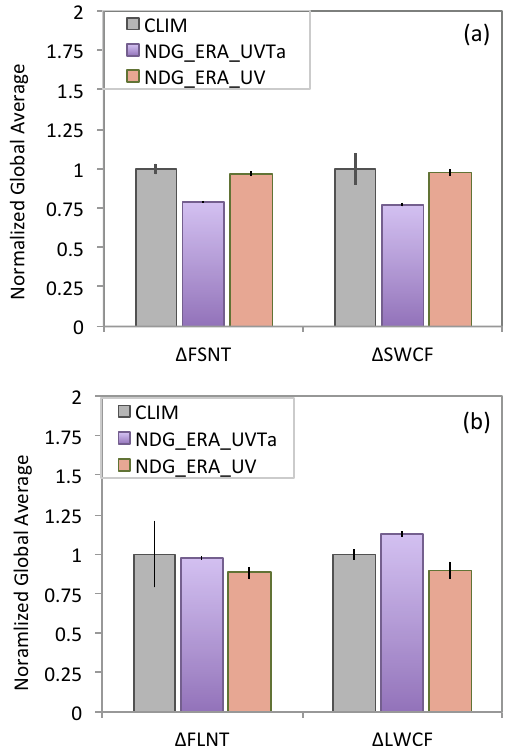
Figure 9. As in Fig. 2 but comparing two alternative nudging strategies (NDG_ERA_UVTa and NDG_ERA_UV) with the free- running CAM5 model